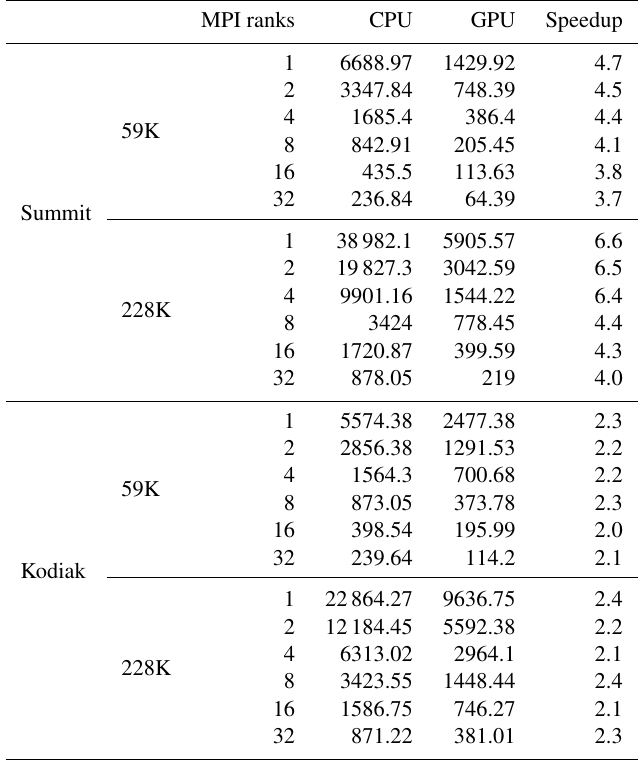
Table 2. The speedups and simulation times associated with offloading one MPI rank exclusively to one GPU on Kodiak and Summit with 59K and 228K mesh sizes for MPI ranks ranging from 1 to